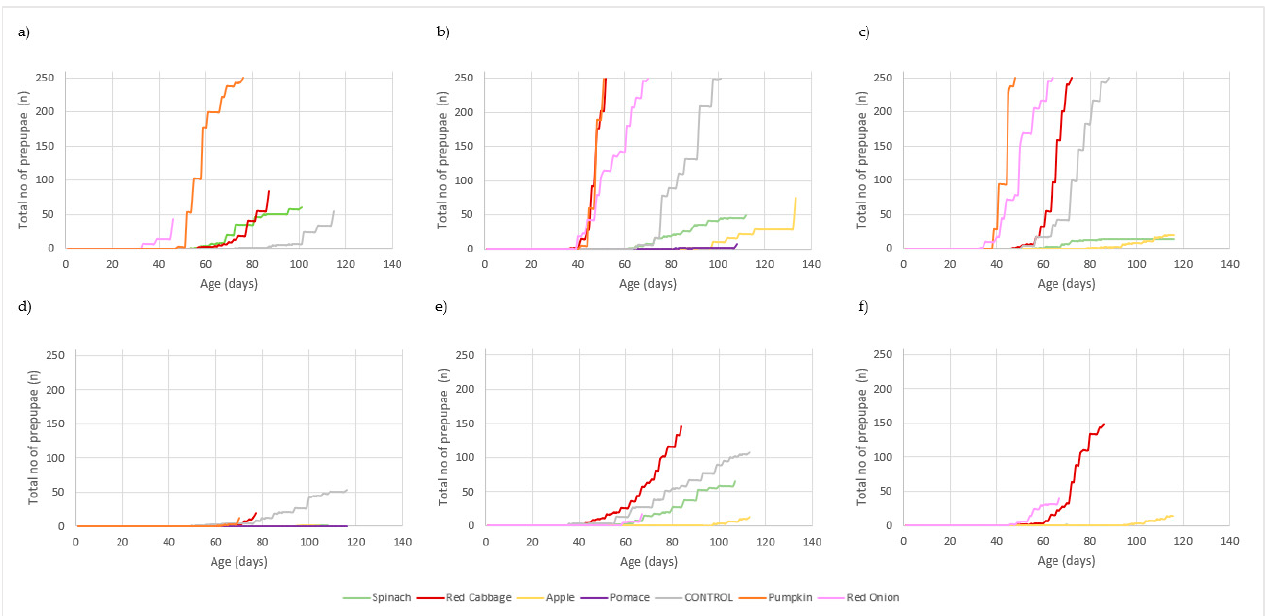
Figure 1. Black soldier fly prepupal yield (sum of total prepupae of all replicates over trial duration) —( a ) 20 °C 70% SM; ( b ) 25 °C 70% SM; (c ) 30 °C 70% SM; ( d ) 20 °C NAT SM; ( e ) 25 °C NAT SM; ( f ) 30 °C NAT SM.